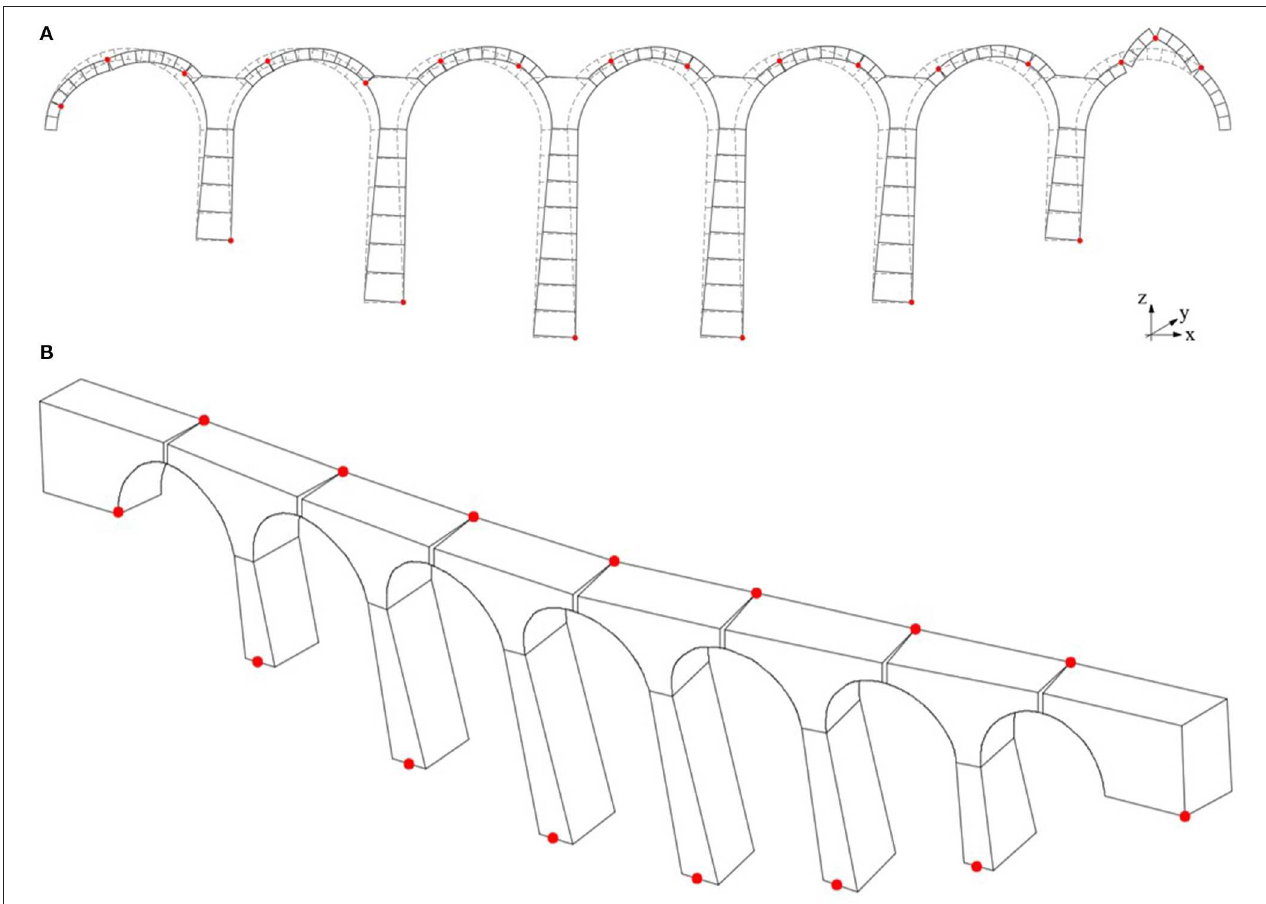
FIGURE 11 | Displayed collapse mechanism from the non-linear kinematic analysis. (A) Side A of the bridge spandrel walls. (B) Side B of the bridge spandrel walls.